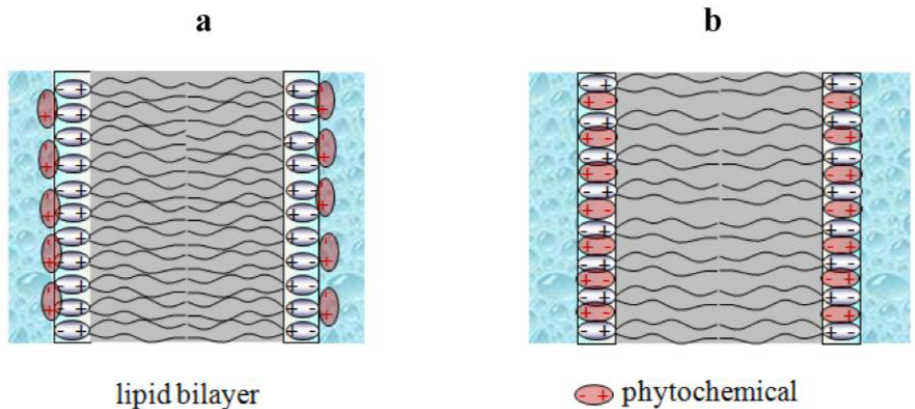
Figure 8. Two different ways of modulating dipole potential with various phytochemicals: ( a ) change in the membrane hydration and ( b ) intercalation of a compound’s own dipoles into the membrane along with disordering of membrane lipids. The grey color indicates the hydrocarbon core of the lipid bilayer; the blue color indicates the membrane bathing solution.